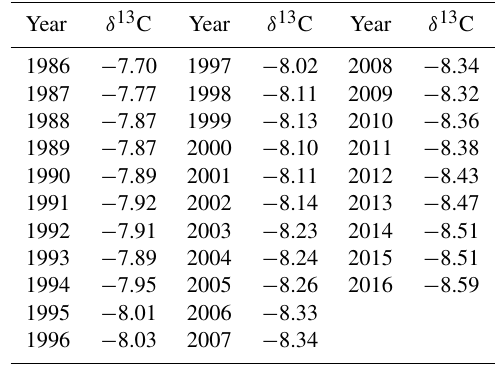
Table 2. Annual average atmospheric δ 13 C values from La Jolla Pier, CA,